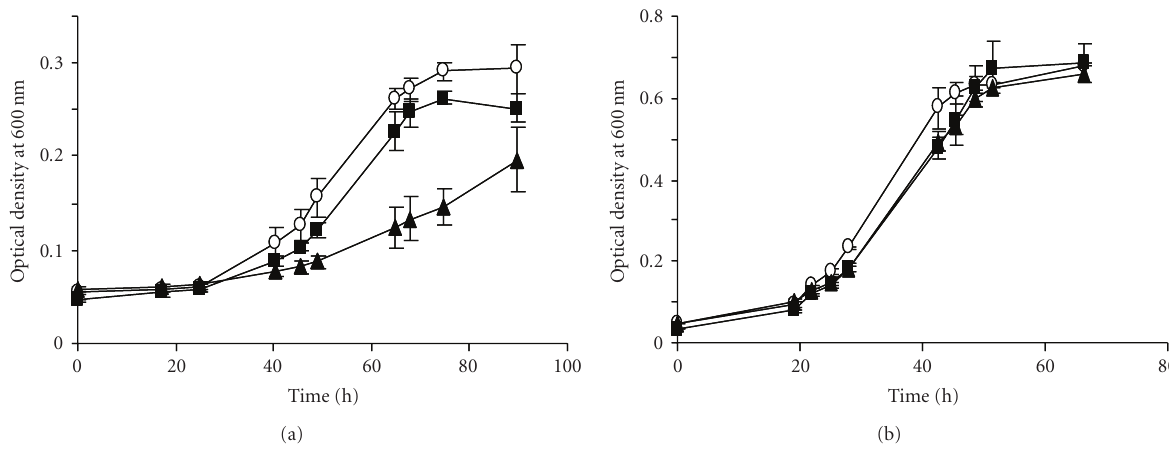
Figure 4: Growth analysis of Δ sRNA 154 versus wild type under nitrogen limitation (a) and under nitrogen su ffi ciency: (b) M. mazei strains were grown in 50mL liquid minimal medium complemented with 150mM methanol as carbon source under nitrogen limiting conditions (a) and with 10mM NH + 4 as nitrogen source (b) under a gas atmosphere of N 2 /CO 2 (80:20). Open circles: wild type; closed squares: M. mazei Δ hpt; closed triangles: M. mazei Δ sRNA 154 . Standard deviations of five replicates for each strain are indicated.